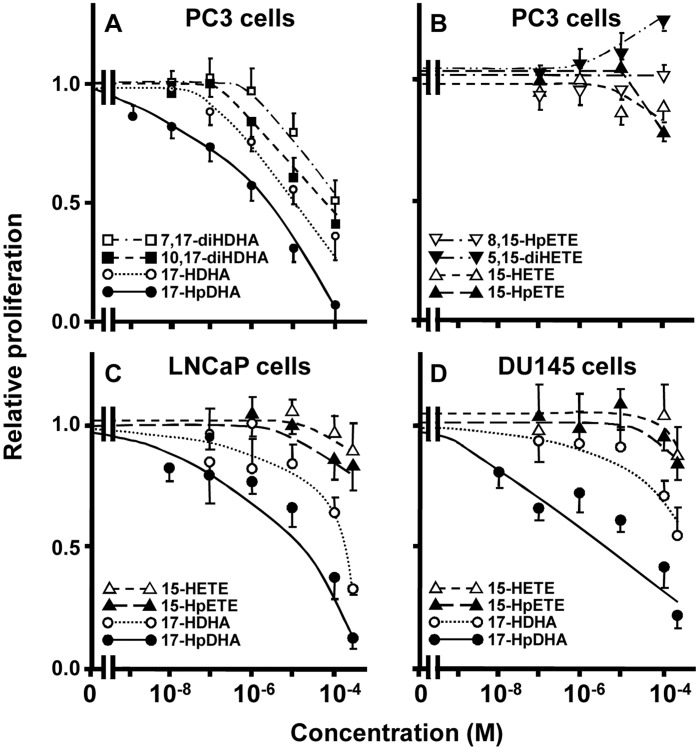
The proliferation responses of PC3, LNCaP, and DU145 prostate cancer cells to selected DHA and AA metabolites.The indicated cell types were incubated for 3 days with the indicated metabolite and their proliferation presented as the mean ± SEM (≥3 independent experiments) fractions of that found in cells treated with the vehicle (culture media) for the metabolites.